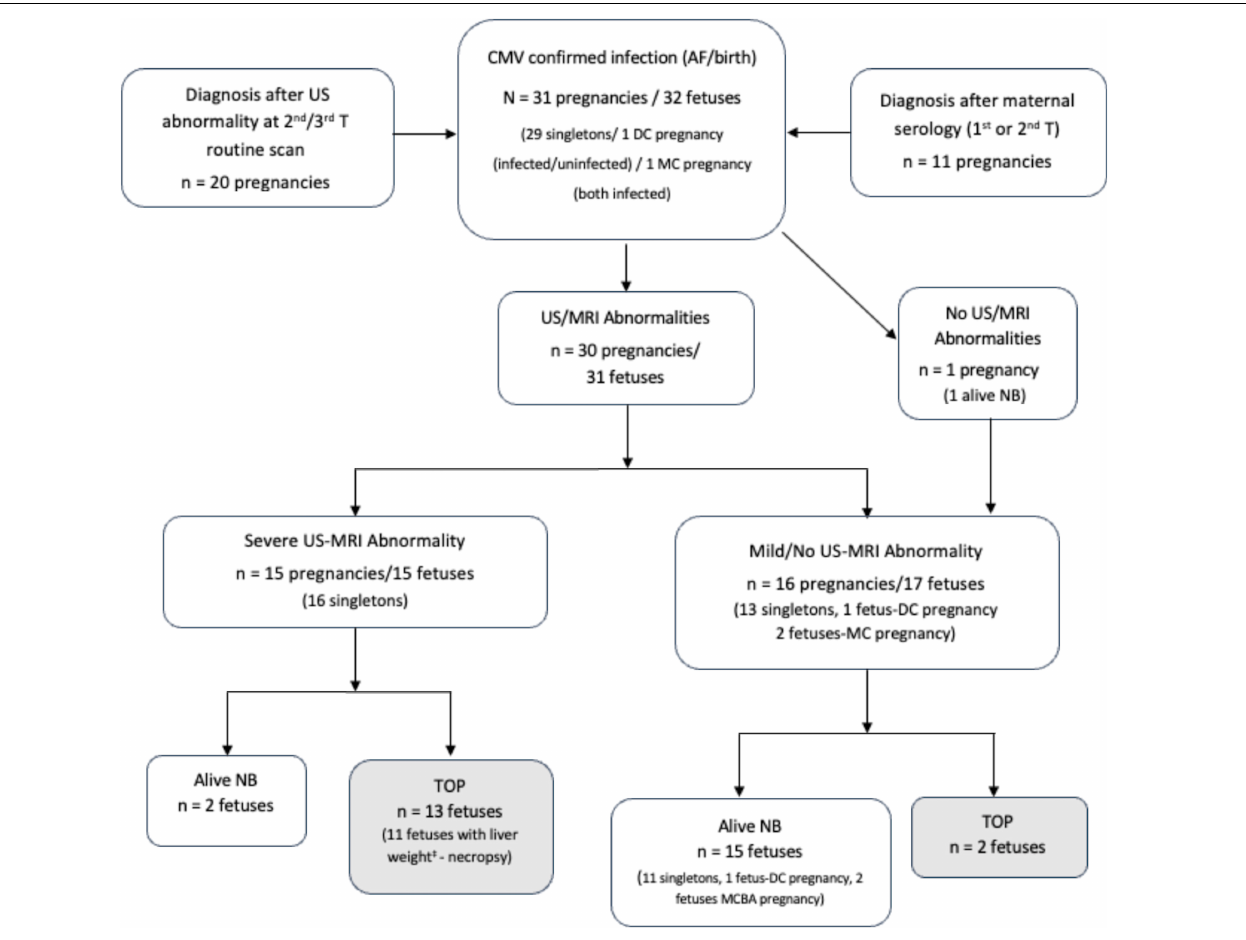
FIGURE 2 | Flowchart: Follow-up of pregnancies with confirmed fetal CMV infection. Description of outcomes according to the severity of infection, anatomopathological examination performed and liver weight at necropsy ‡ . DC, dichorionic; MC, monochorionic; AF, amniotic fluid; US, ultrasound; MRI, magnetic resonance imaging; TOP, termination of pregnancy; NB,